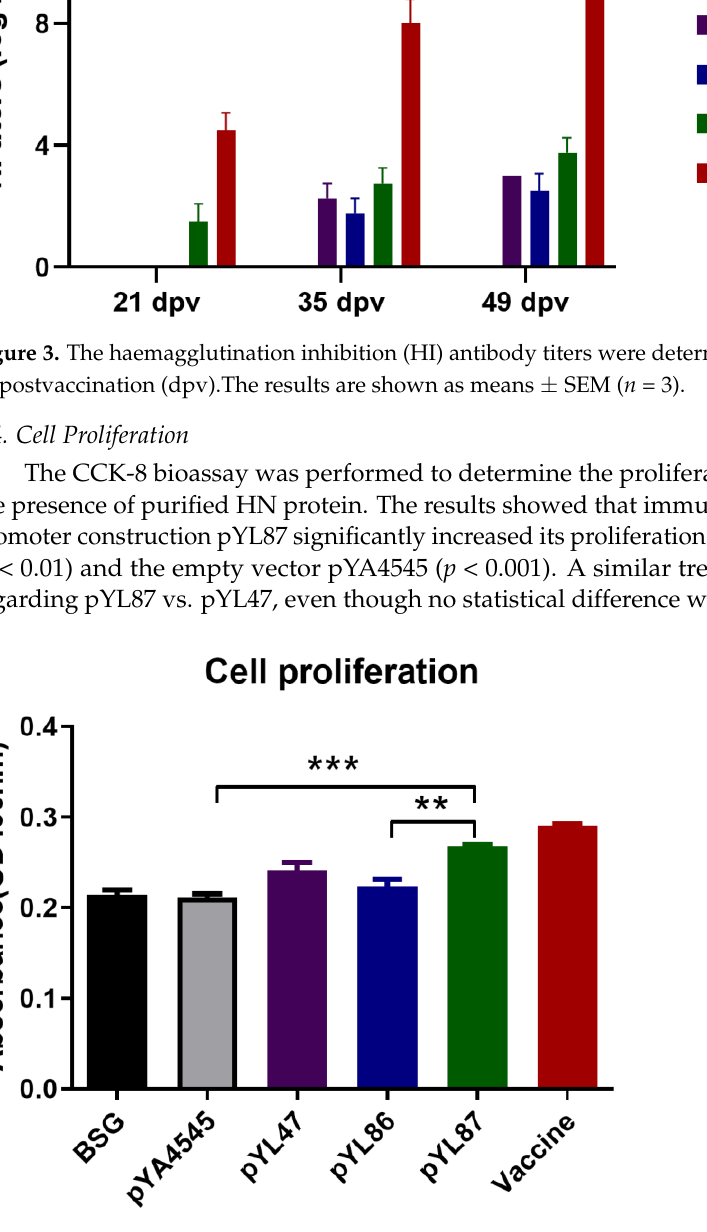
Figure 4. Cell proliferation assay. The spleen cells were separated and stimulated with purified HN protein, followed by observation with CCK-8 assay. The results are indicated as means ± SEM ( n = 3). The statistical significance was calculated by one-way ANOVA and a Tukey post-test. **, p < 0.01; ***, p < 0.001.